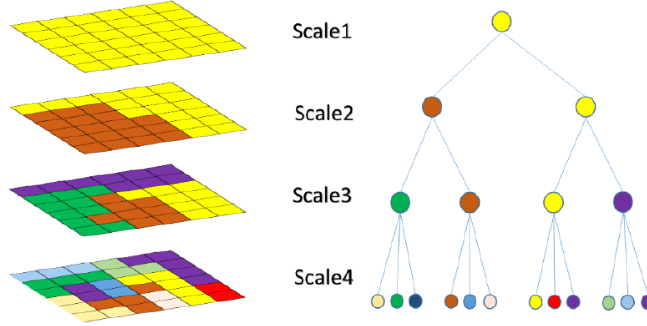
Figure 6. Four-scale hierarchical dendrograms of image superpixels.